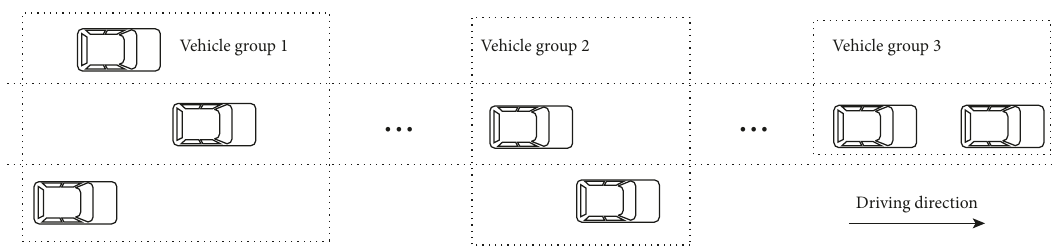
Figure 3: Schematic diagram of vehicle group division.